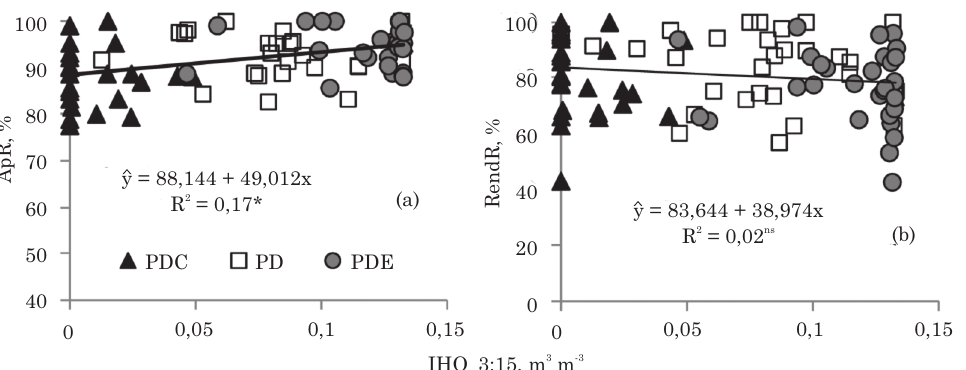
Figura 3. Regressão linear entre altura de plantas relativa (ApR) (a) e rendimento de grãos relativo (RendR) (b), em função do IHO_3:1,5. * significativo a 5 %; ns não significativo.